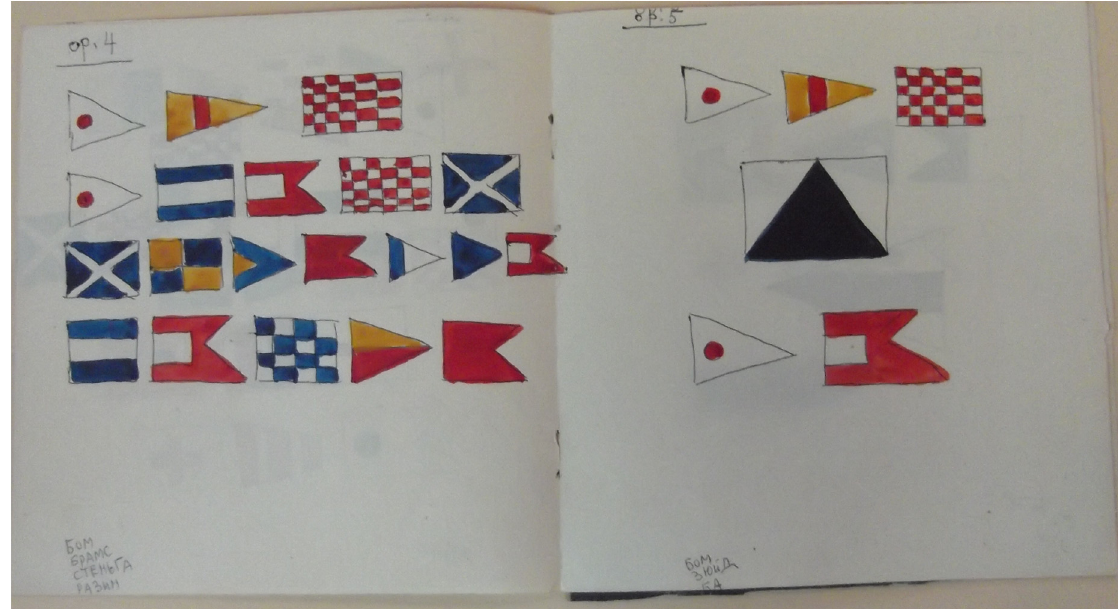
Figure 9. Pages from ‘Stikhi dlia matrosov’.